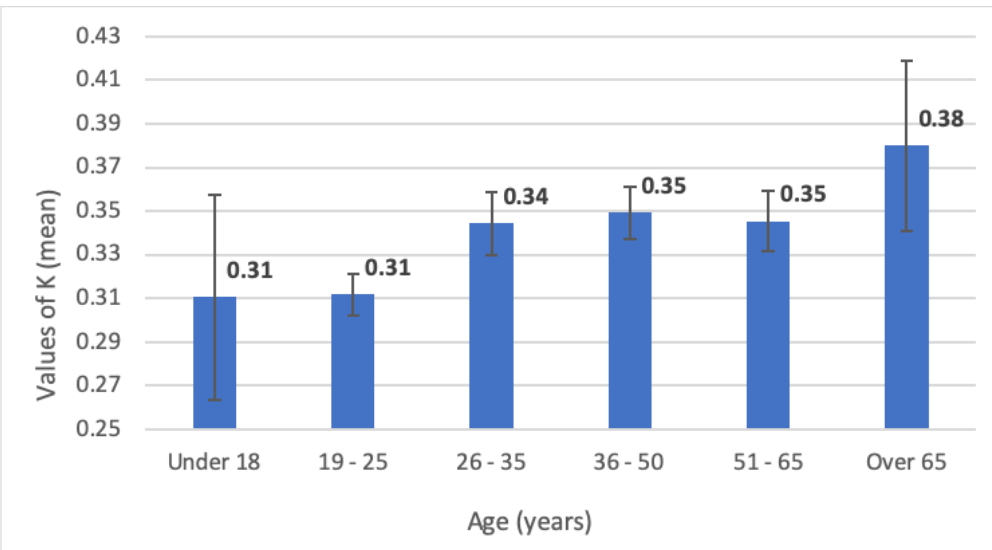
Figure 1. Graphical representation of K mean values (± 95% CI) across age subgroups.